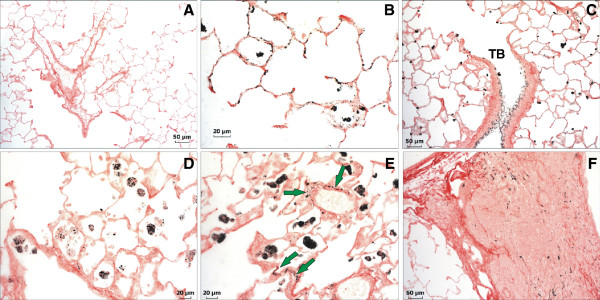
Autometallographic evaluation of tissue distribution of QD 1 and 14 days post-exposure. Silver enhancement staining of QD in lung tissue of rats 1 (A-C) and 14 (E-F) days after intratracheal instillation with 12.5 μg of QD-NH2 or QD-COOH, or PBS (control). (A) Lung from a control rat 1 day post-exposure showing no silver staining. (B) Silver enhancement of QD-COOH in the lung of a rat 1 day post-exposure. QD can be seen distributed along alveolar epithelium and in AM. (C) QD-NH2 enhanced with silver in rat lung 1 day after instillation. Distribution of QD-NH2 does not appear to differ drastically from QD-COOH 1 day post-exposure in terms of deposition in the alveolar region and in macrophages; however, there does appear to be slightly more deposition in the airways as shown in panel C. QD can also be seen throughout the epithelium of a terminal bronchiole (TB). By day 14, QD-NH2 (D) and QD-COOH (E) appear to be more concentrated in AM with a lesser amount in the tissue. QD-COOH can still be found in the interstitium and around vessels (green arrows). Both forms of QD were observed in bronchoalveolar lymphoid tissue (BALT). Silver enhancement of QD-COOH in BALT 14 days post-exposure is shown in panel F.